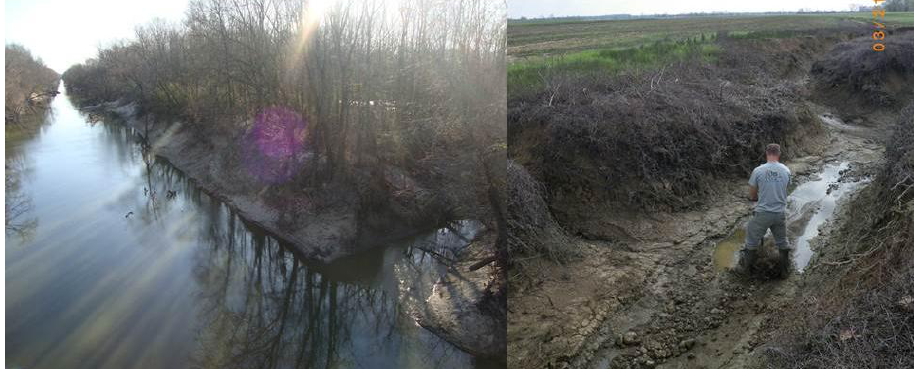
Figure 2. Agricultural drainage can cause stream incision at multiple spatial scales. At left, the Loosahatchie River, north of Memphis, Tennessee, USA. Channelization has resulted in stream incision, not only of the main channel, but also of tributaries, as seen by the difference between the water level and top bank of the stream flowing into the main channel. At right is an agricultural drainage ditch near Yazoo City, Mississippi, USA. Although the channel is sinuous, high peak flows have resulted in bed degradation and mass wasting. Although this photo was taken shortly after a substantial rainfall event the channel holds little